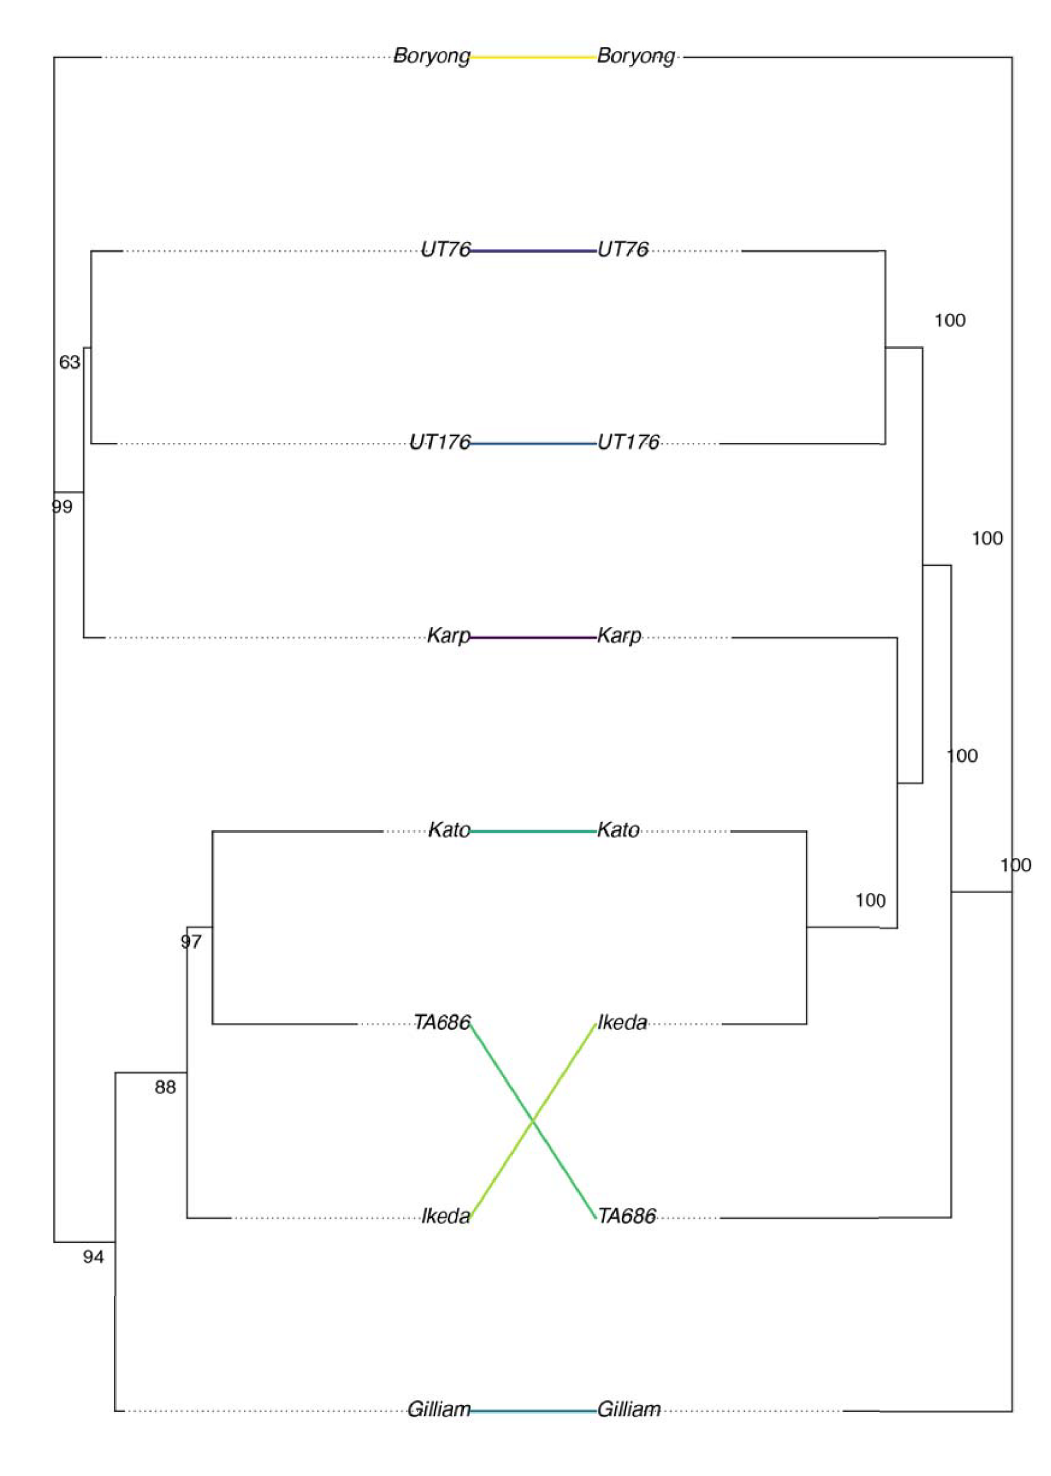
Fig 4. Phylogenetic trees generated from the 56kDa antigen sequence (left) and the sequence of the 657 core genes (right). The tree was inferred using the maximum likelihood method implemented in RaxML, and bootstrap values were calculated with the RaxML rapid bootstrap